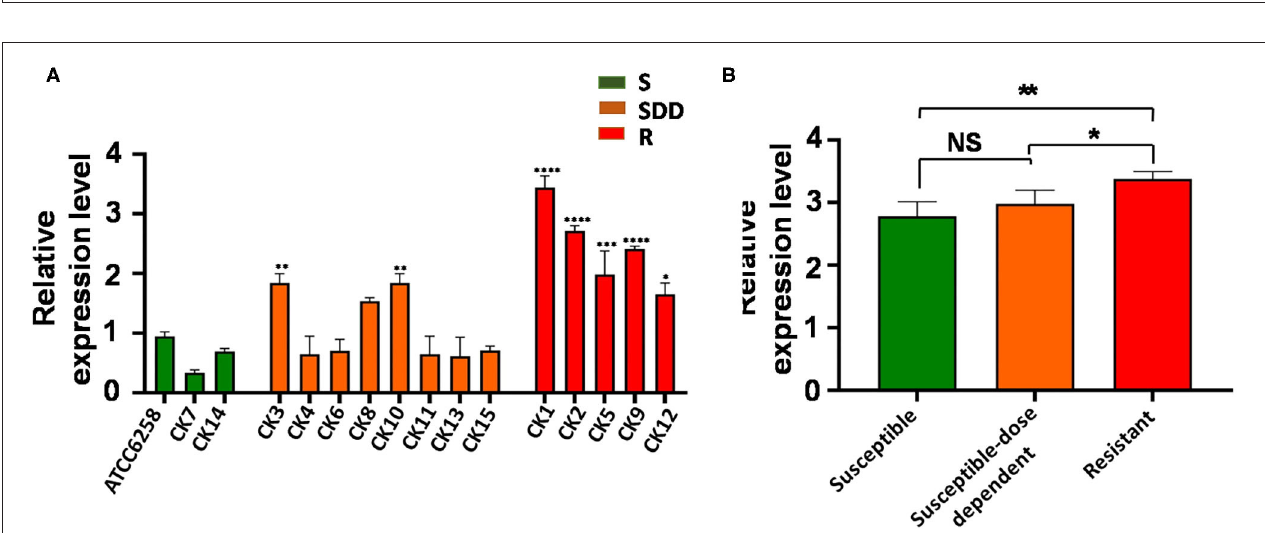
FIGURE 3 | ABC2 relative gene expression levels in three groups of C. krusei clinical isolates. (A) Relative levels of ABC2 mRNA in all the C. krusei clinical isolates. ABC2 gene expression levels were quantified and normalized relative to the reference gene, GAPDH; S, itraconazole-susceptible; SDD, itraconazole-susceptible dose dependent; R, itraconazole-resistant. Asterisks indicate that the difference between field isolates with the reference strain ATCC 6258 is significant compared to the reference strain ATCC 6258: * p < 0.05 in CK12 with ATCC6258; ** p < 0.01 in CK3, CK10 with ATCC6258; *** p < 0.001 in CK5 with ATCC6258; and **** p < 0.0001 in CK1, CK2, CK9 with ATCC6258. (B) Log10 + 3 fold increase of gene expression levels in three groups (NS, no significance in SDD compared with S; * p < 0.05 in R with SDD; ** p < 0.01 in R with